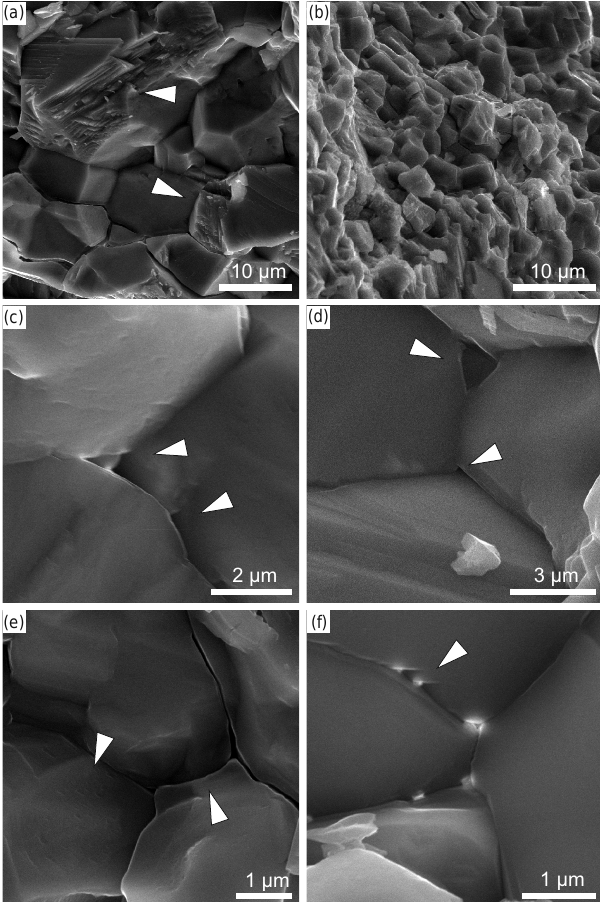
Figure 5. SE images of broken specimens. (a) Slightly coarser grained area showing how grains larger than 15µm break along the cleavage, while small grains break along their boundaries. (b) Fine equigranular calcite grains showing crystal faces. (c) Small cavi- ties at grain triple junctions and grain boundaries next to ledges. (d) Cavities at grain triple junctions. (e) Grain boundary openings appearing to be closed by flowing grains. Note the small pores on the grain surface of the left grain. (f) Small cavities with the same orientation piling up at the grain